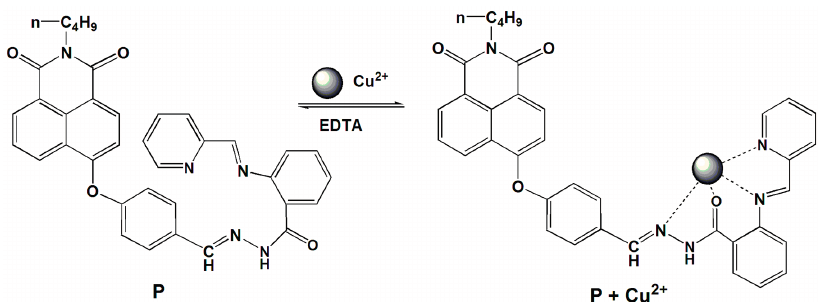
Figure 6. Fluorescence spectra in ethanol-water solution (3:2, v:v, 50 mM